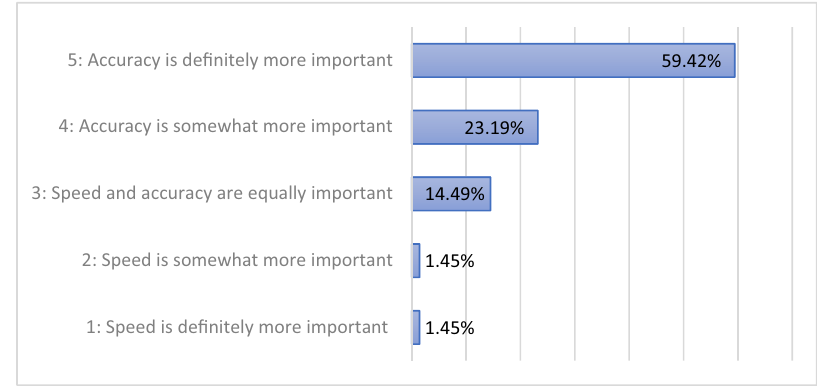
Figure 5: Responses to Statement 14 “ In your opinion, which of speed or accuracy is more important for a professional translator? ” .